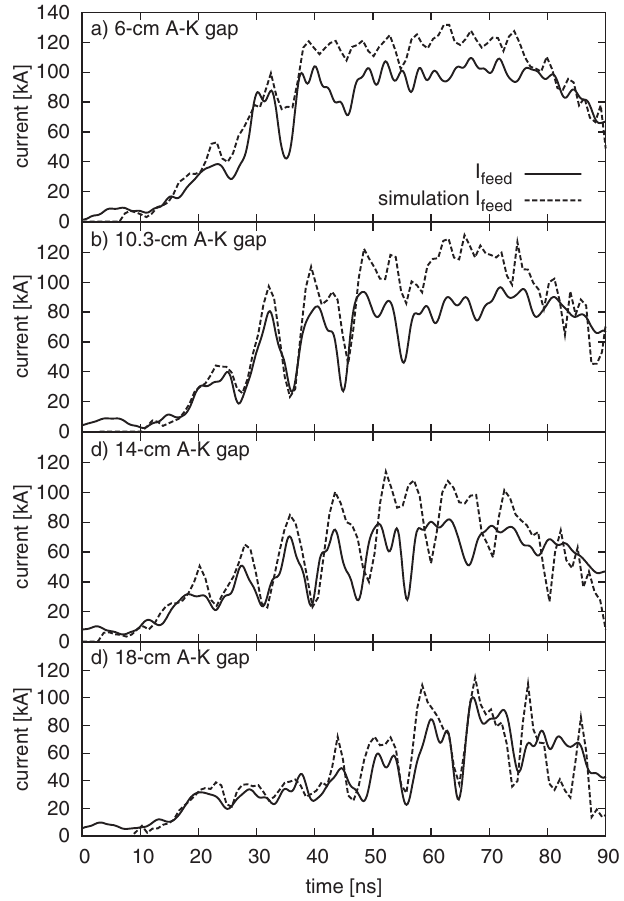
FIG. 11. Comparison of simulated I 10.3-, 14-, and 18-cm A-K gaps in the dustbin/knob configura- tion. The probe location is shown in Fig.